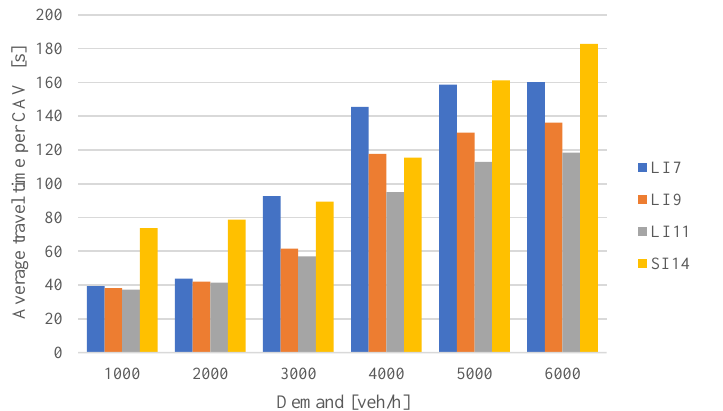
Figure 5. Average travel time per vehicle for Lightless Intersection (LI) and Signalized Intersection (SI) scenarios. The numbers indicate the value of desired speed (in m/s) for every scenario.